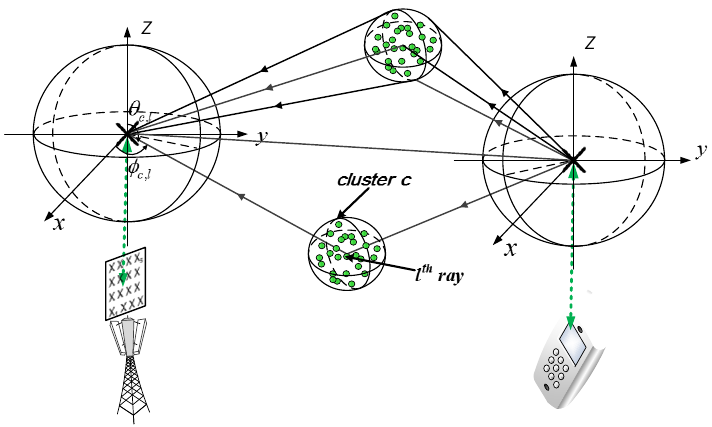
Figure 1. The illustration of a 3D MIMO channel model